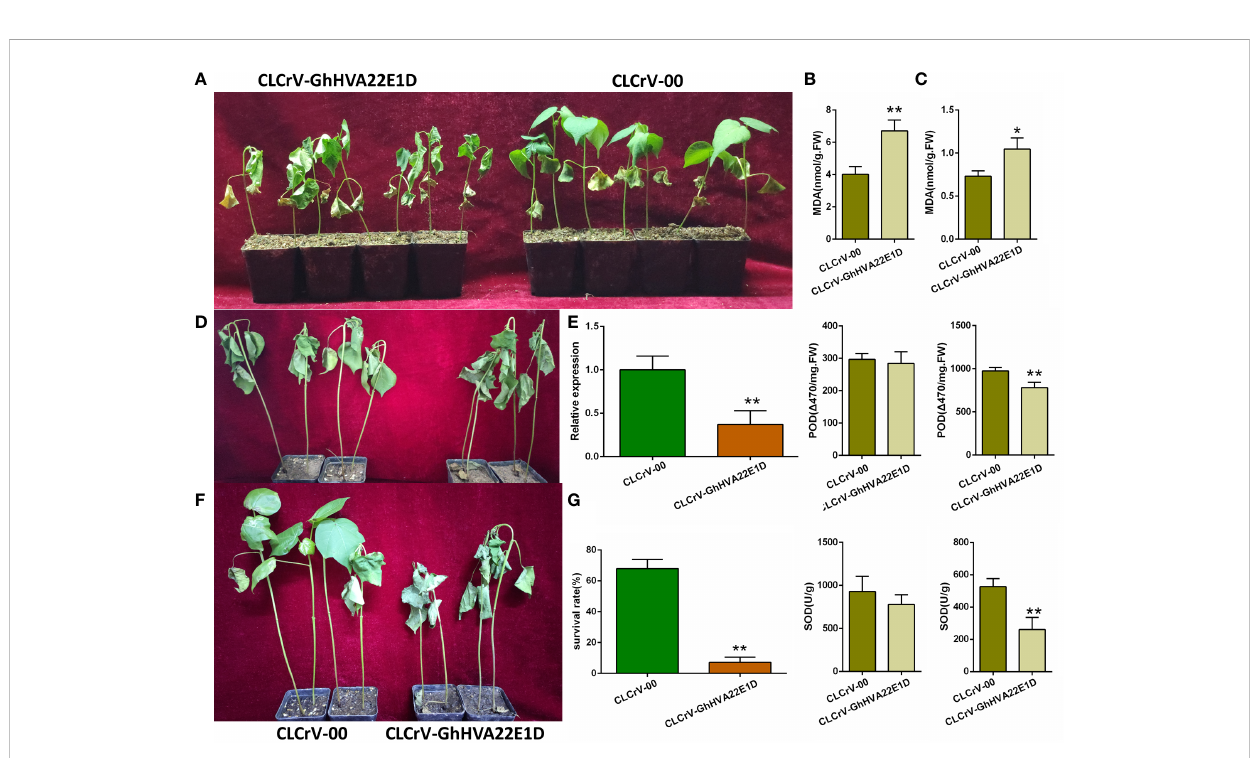
FIGURE 9 Silencing of GhHVA22E1D leads to reduced salt and drought tolerance in G hirsutum . (A) Phenotype of cotton after soaked in 400 mM NaCl solution for 10 days. Detection of POD and SOD activities and MDA content in cotton leaves (B) and roots (C) after salt stress. (D) The phenotype of cotton after 14 days of natural drought. (E) Silencing ef fi ciency of CLCrV- GhHVA22E1D plants. Phenotype (F) and survival rate (G) of cotton plants after 2 days of re-watering. The results are the mean of three replicates. *p ≤ 0.05, **p ≤ 0.01 (Student t -test).